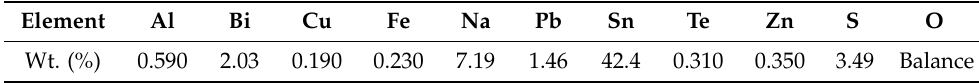
Table 1. The chemical composition of the tin-bearing material. Element